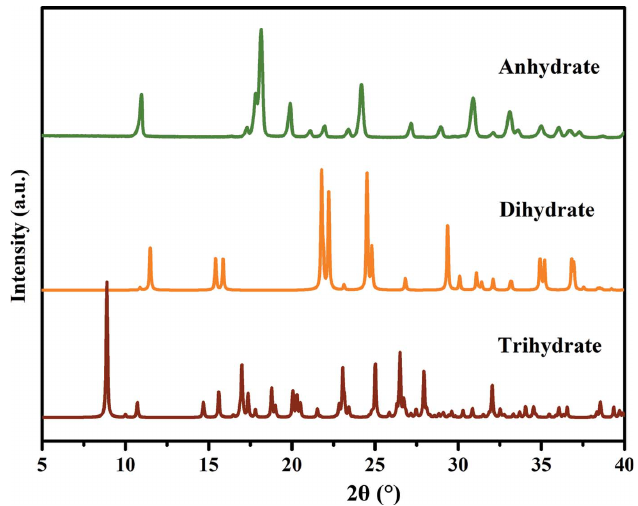
Figure 2 PXRD profiles for the three crystal forms of PDA-OXA.